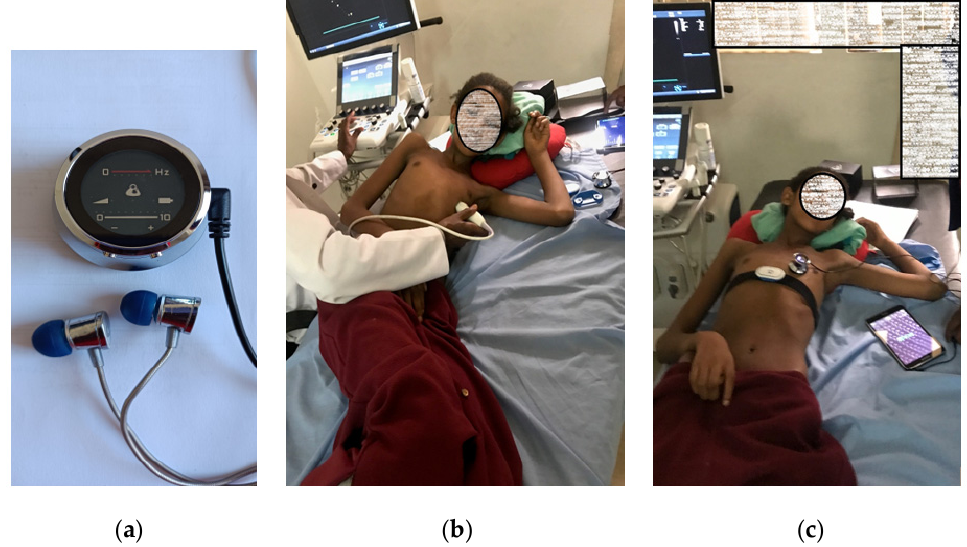
Figure 3. The data collection setup. ( a ) Thinklabs One ™ electronic stethoscope, Thinklabs Medical LLC, CO, USA ( b ) transthoracic echocardiographic confirmation, and ( c ) the phonocardiogram recording.